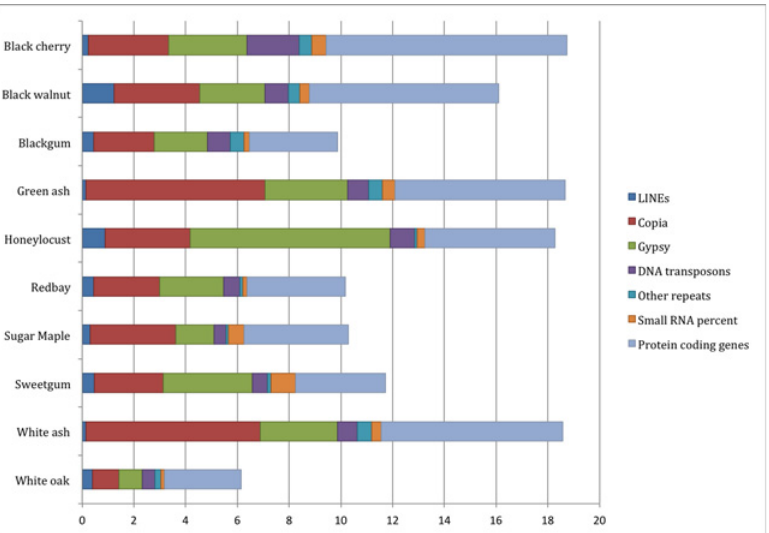
Fig 1. Identified repetitive elements and genes in genomic reads. The percent of reconstructed fragments with sequence similarity to known plant repetitive elements and gene sequences vary across species. The majority of identified repetitive elements originate from the retrotransposon classes of Gypsy and